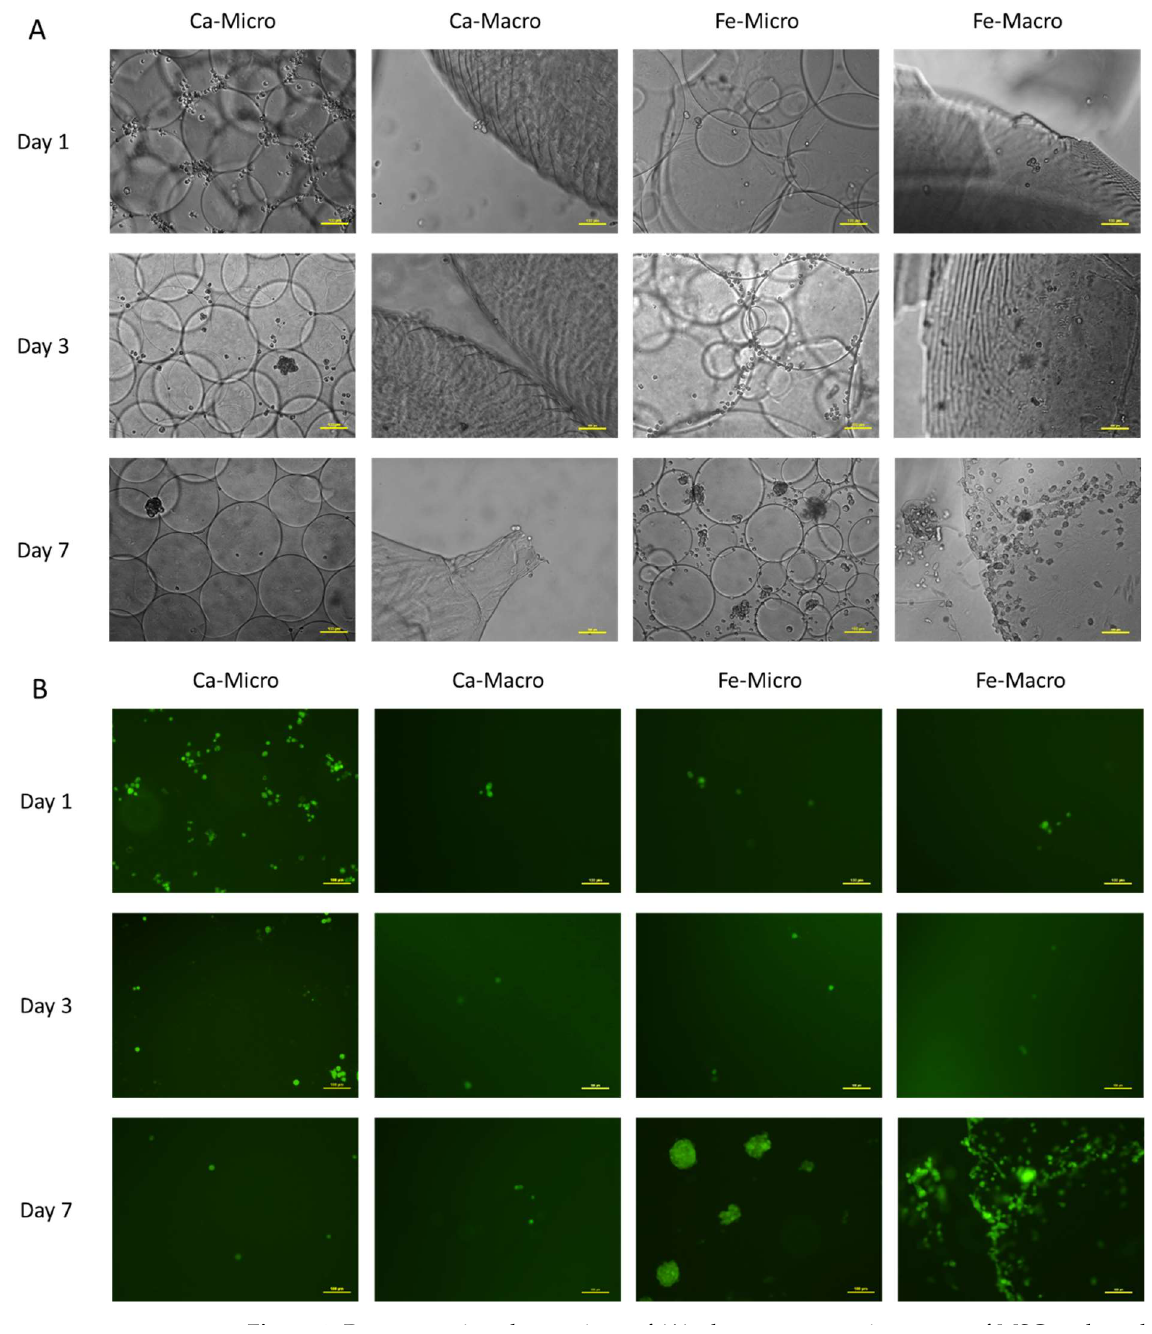
Figure 8. Representative observations of ( A ) phase contrast microscopy of MSCs cultured on alginate beads over time, and ( B ) fluorescence microscopy of MSCs cultured on alginate beads over time. Cells appear green thanks to self-produced GFP. Scale bar: 100 µm.